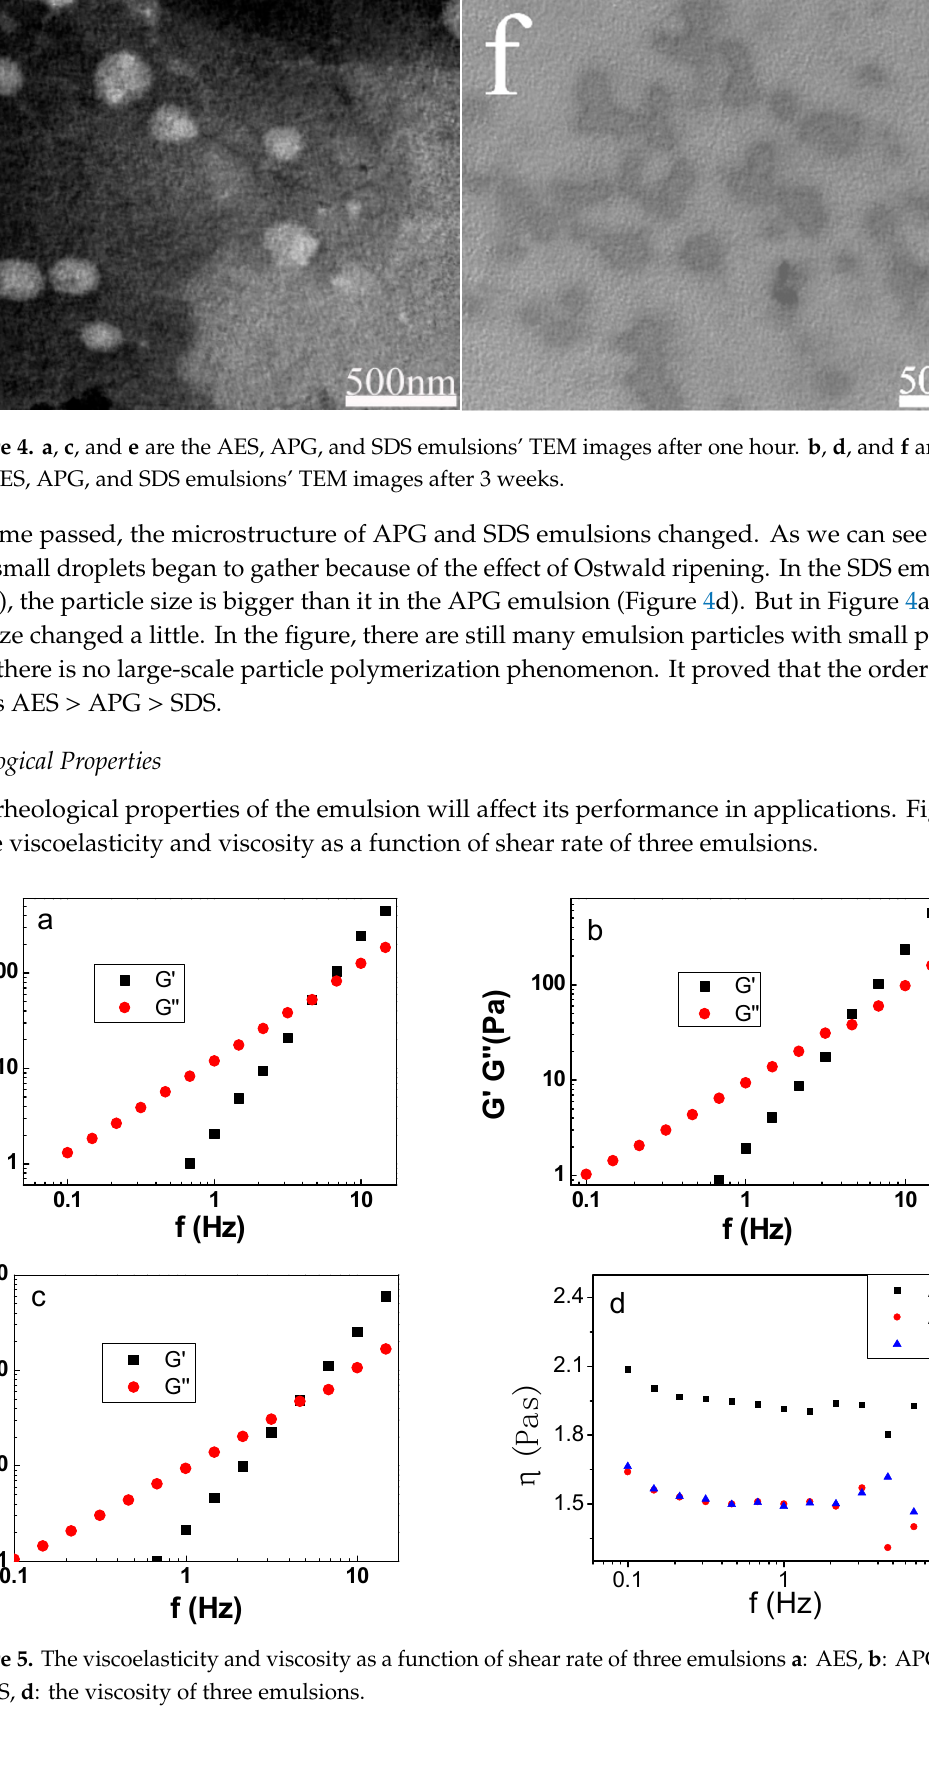
Figure 4. a , c , and e are the AES, APG, and SDS emulsions’ TEM images after one hour. b , d , and f are the AES, APG, and SDS emulsions’ TEM images after 3 weeks.